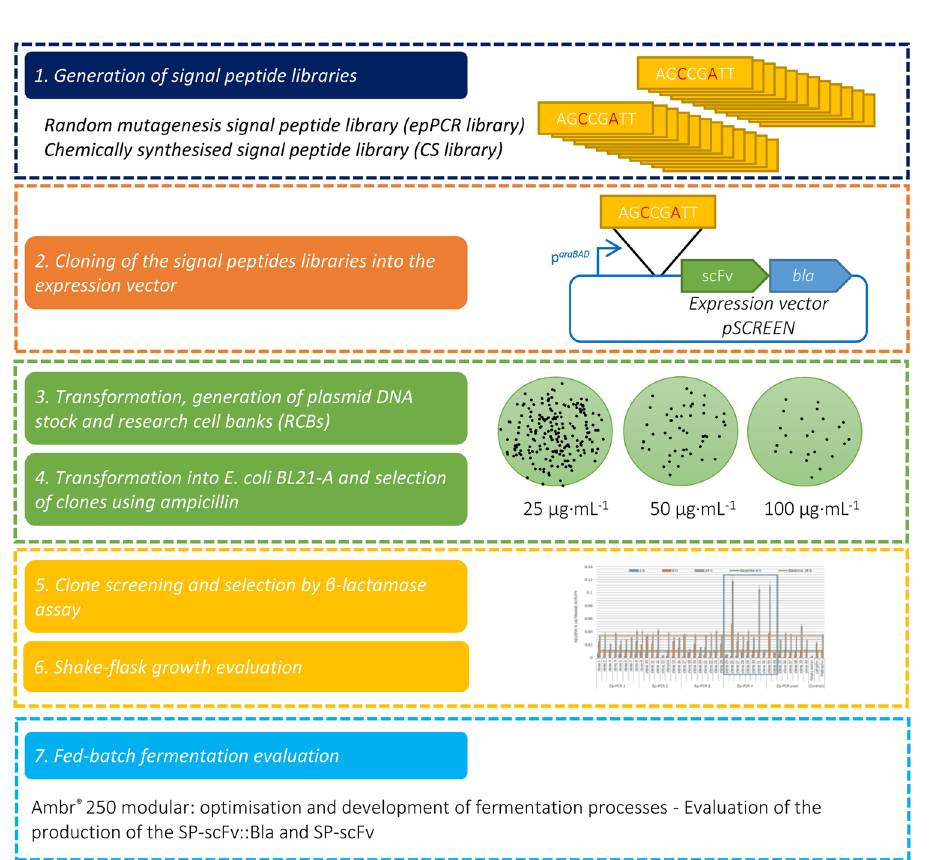
Figure 3. Workflow for β -lactamase screening for periplasmic protein